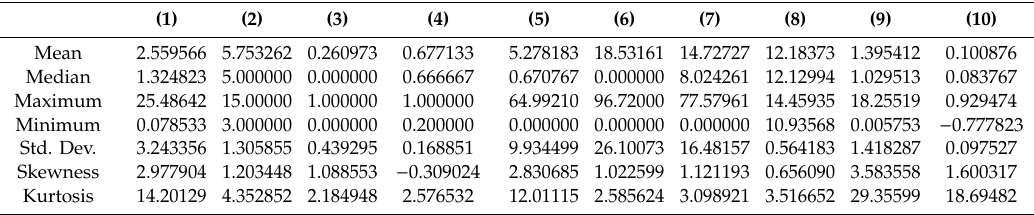
Table 2. Descriptive